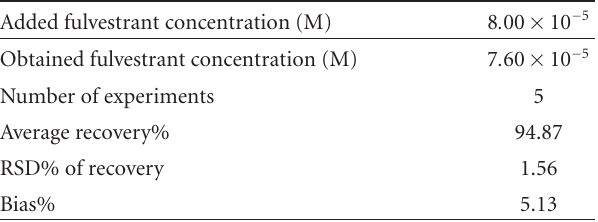
Table 3: Results obtained from fulvestrant determination from spiked serum.